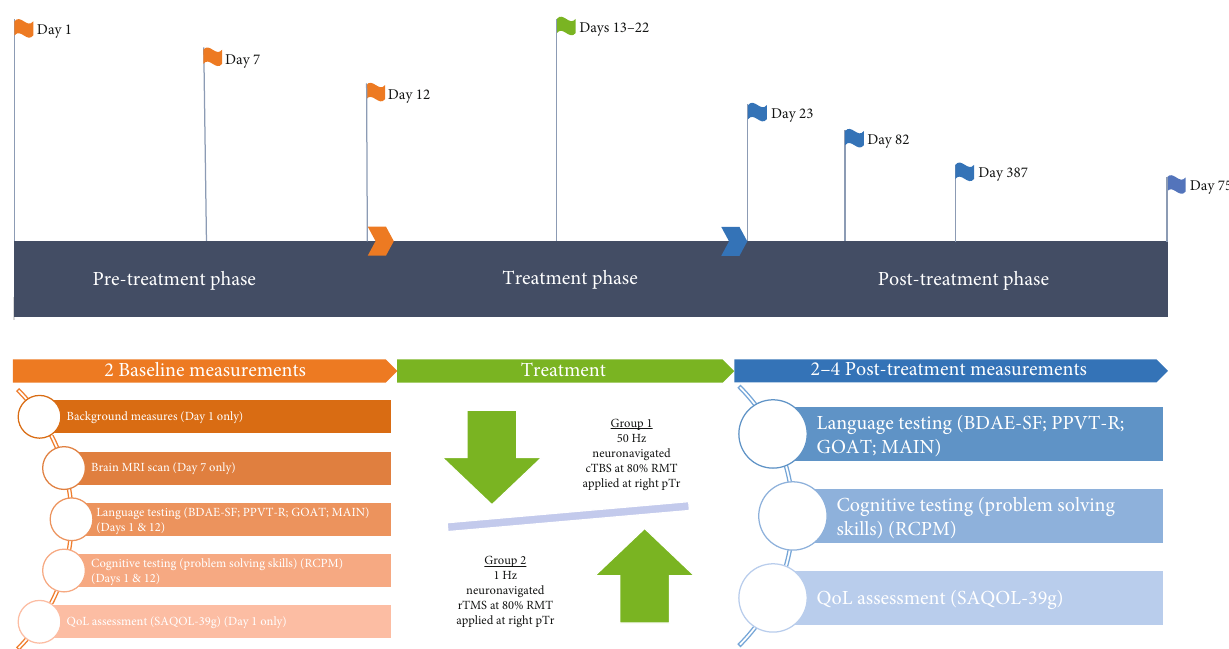
Figure 2: Experimental timeline of the